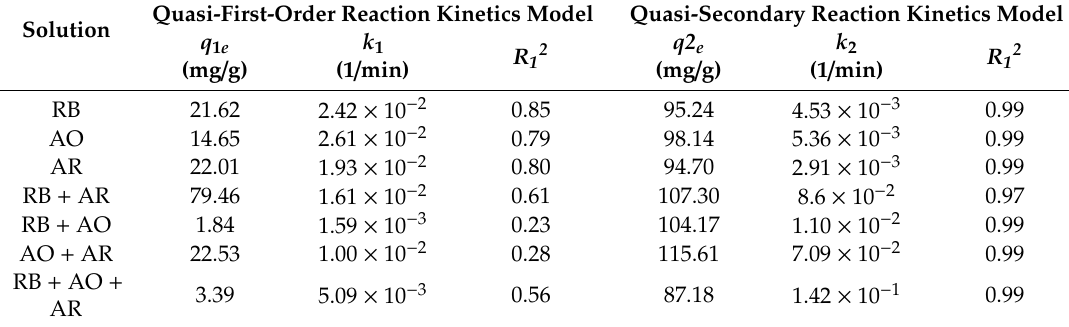
Table 1. The adsorption kinetics model with various dyes, the adsorption test was conducted with 200 mg / L Acid Orange II and 2 g / L modified sepiolite under oscillation rate of 180 r / min and initial pH value of 1.